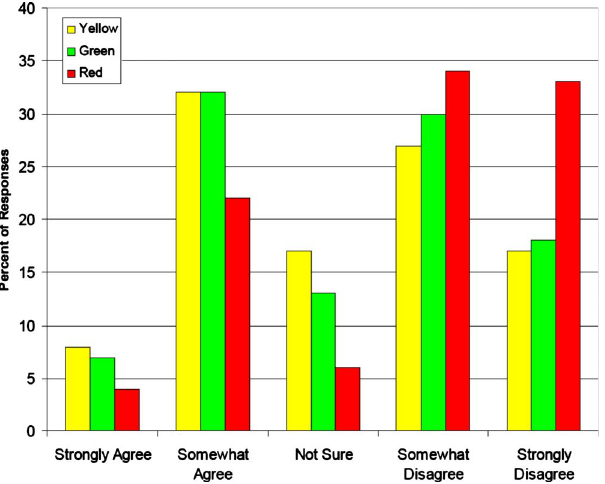
FIG. 4. (cid:1) Color (cid:2) Example Item—distribution of student re- sponses to the statement: It is awkward to ask the professor ques- tions in